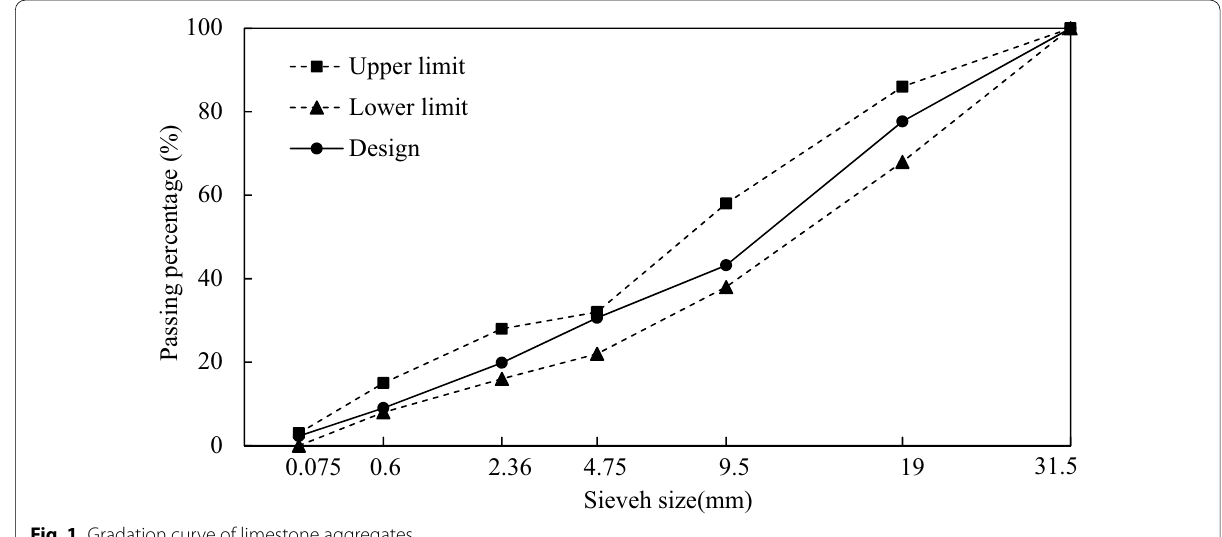
Fig. 1 Gradation curve of limestone aggregates.